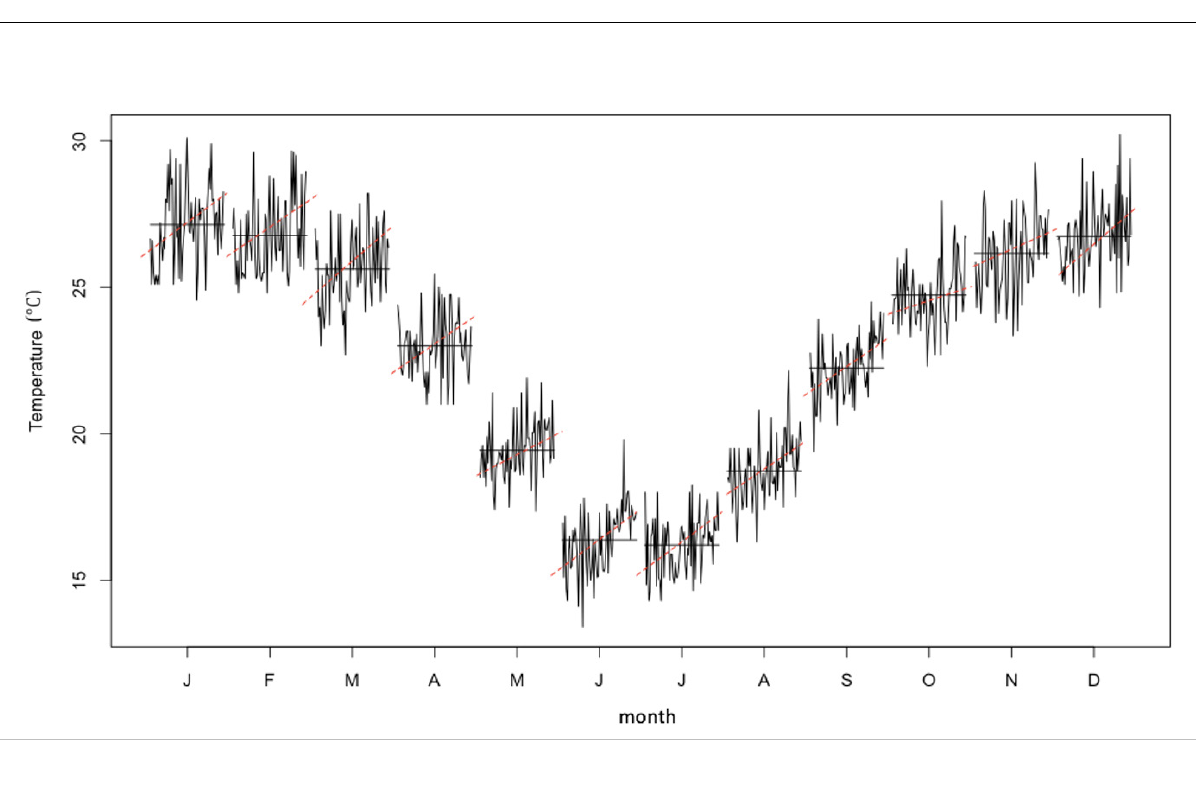
Figure 2: Mean monthly maximum temperatures for northernmost Limpopo Province, 1950–2016. Horizontal lines represent monthly mean values and red dotted lines represent trend lines.